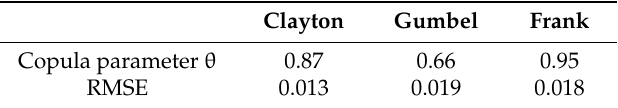
Table 3. Copula parameters and root mean square error (RMSE) for Clayton, Gumbel, and Frank copula types.